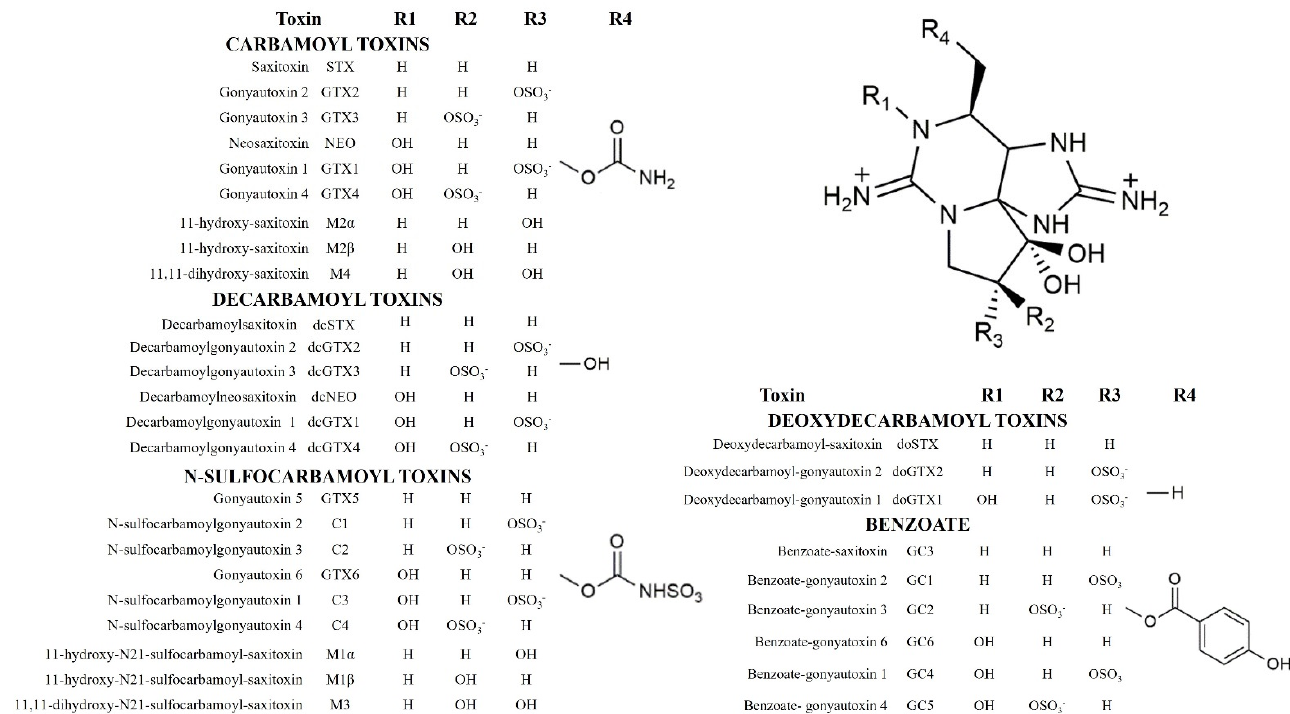
Figure 1. For fifteen analogs, a Toxicity Equivalency Factors (TEFs) list was compiled by European Food Safety Authority EFSA [2].